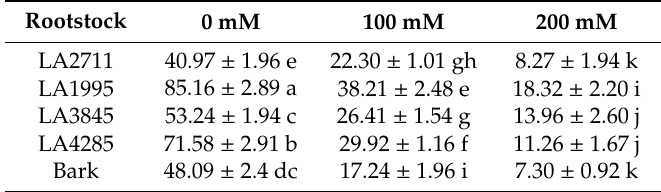
Figure 2: Effect of salt treatments and rootstocks on ( A ) plant height, ( B ) number of branches, ( C ) SPAD reading, and ( D ) plant dry weight. Different letters indicate significant differences between treatments (Tukey test at p < 0.05). Table 5. Analysis of variance (mean square) of tomato growth attributes. Table 6. Fresh weight attribute as a ff ected by Salinity × Rootstock interaction.